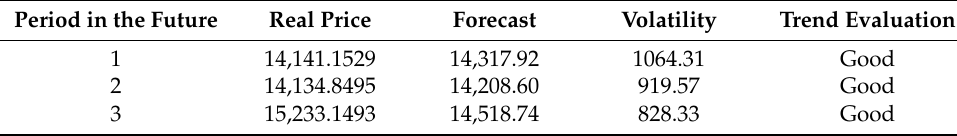
Table 16. Forecasts of the eight-terms group of the Shenzhen Index. Period in the Future Real Price